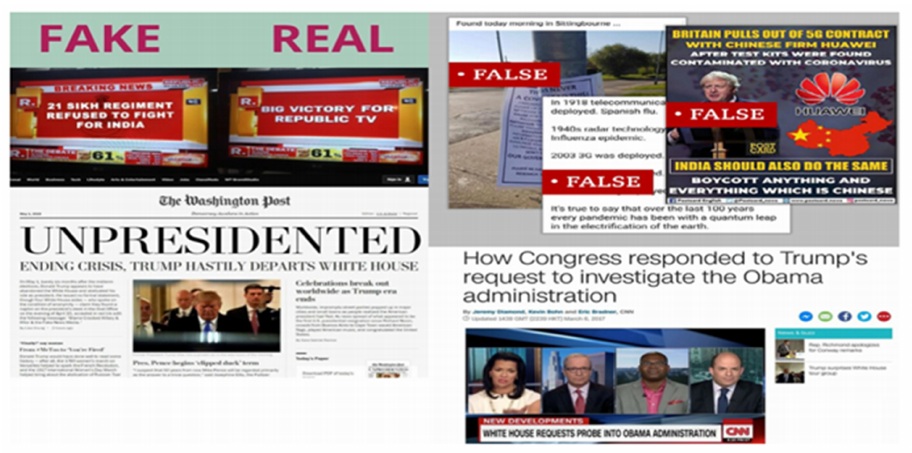
Figure 1. Examples of some fake news